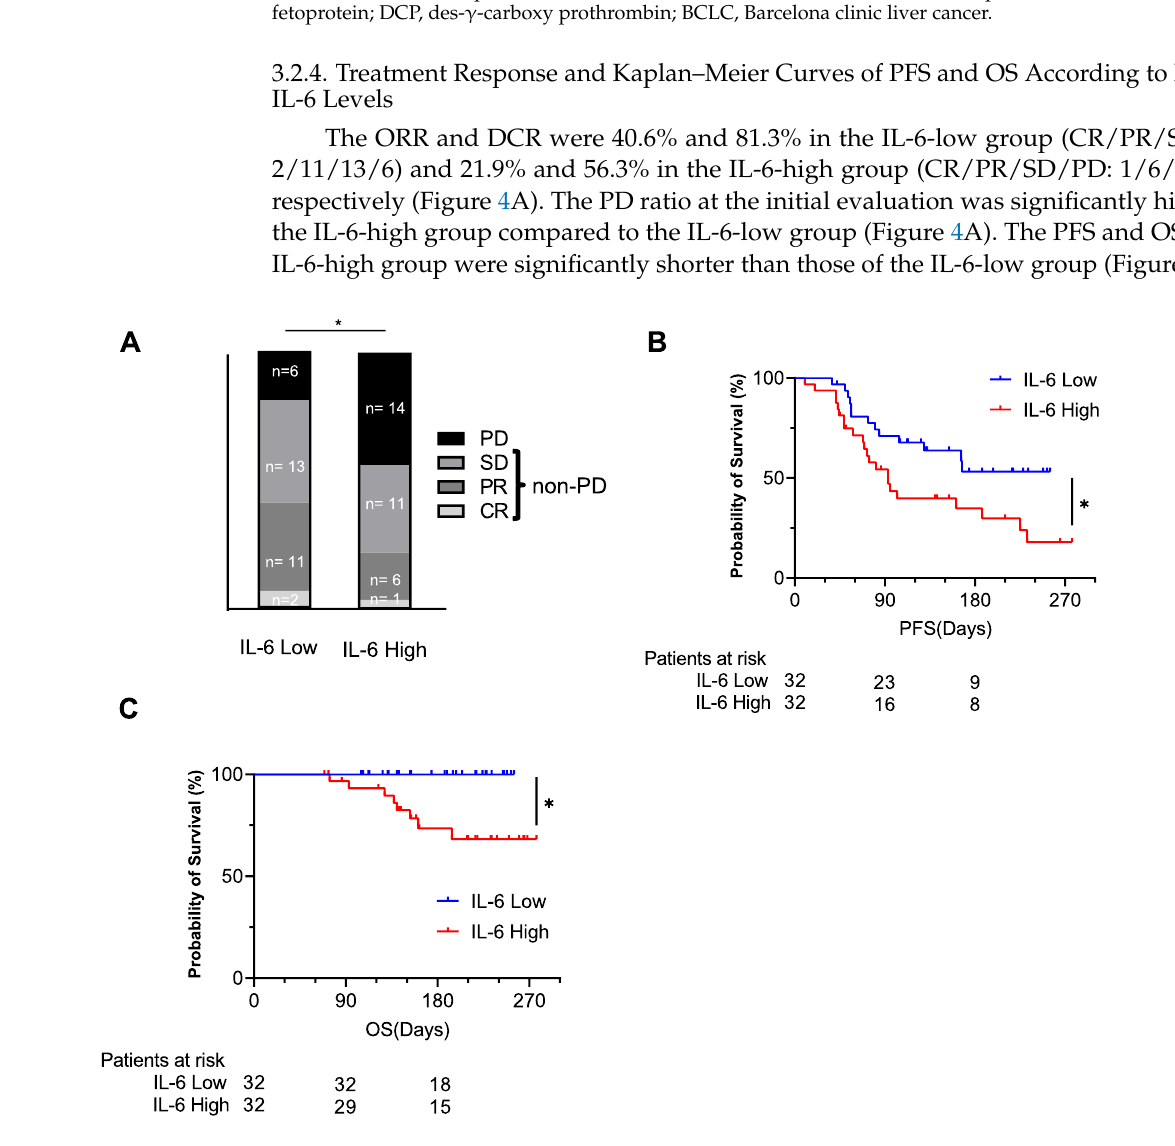
Figure 4. The baseline plasma IL-6 level was examined by ELISA. The patients were divided into 2 groups by the median value of plasma IL-6. The best response to the treatment in each group ( A ) (* p < 0.05 by chi-squared test, PD vs. non-PD) and the Kaplan – Meier curves of PFS ( B ) and OS ( C ) for each group (* p < 0.05). CR, complete response; PR, partial response; SD, stable disease; PD, pro-